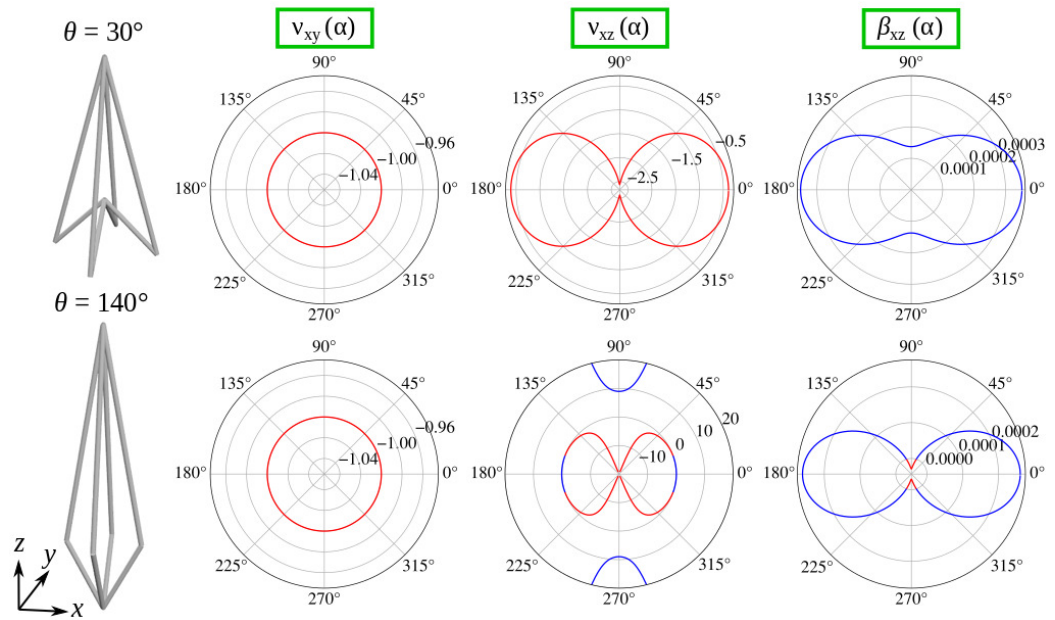
Figure 4. Poisson’s ratio and linear compressibility of two specific configurations of the considered system, where θ = 30 ◦ ( θ < θ 0 ) and θ = 140 ◦ ( θ > θ 0 ). Blue and red lines indicate positive and negative values of a given mechanical property respectively. For all of the results, l a / l b =